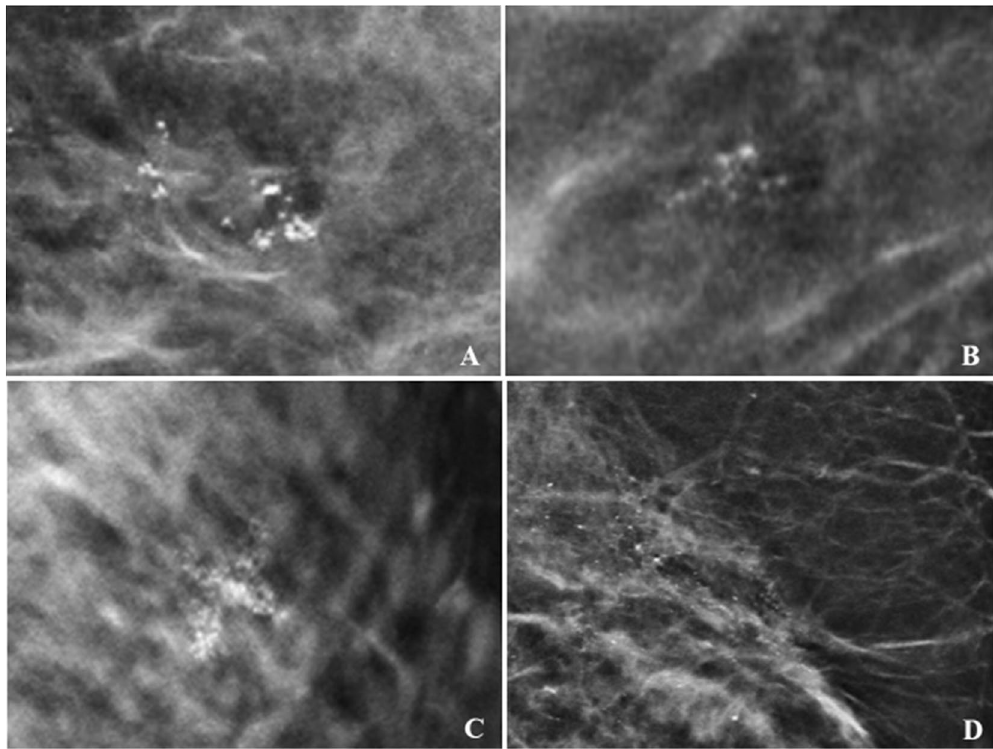
Figure 3. Calcifications morphology with benign histopathology on VABB. Example of coarse heterogenous in grouped distribution – fibrocystic ( A ). Amorphous in grouped distribution – no malignancy ( B ). Fine pleomorphic in regional distribution – no malignancy (after MDT discussion: discordant lesion) which revealed fibrocystic disease in surgical HPE ( C ). Fine linear in segmental distribution – UDH (after MDT: discordant lesion) which revealed fibrocystic disease in surgical HPE ( D